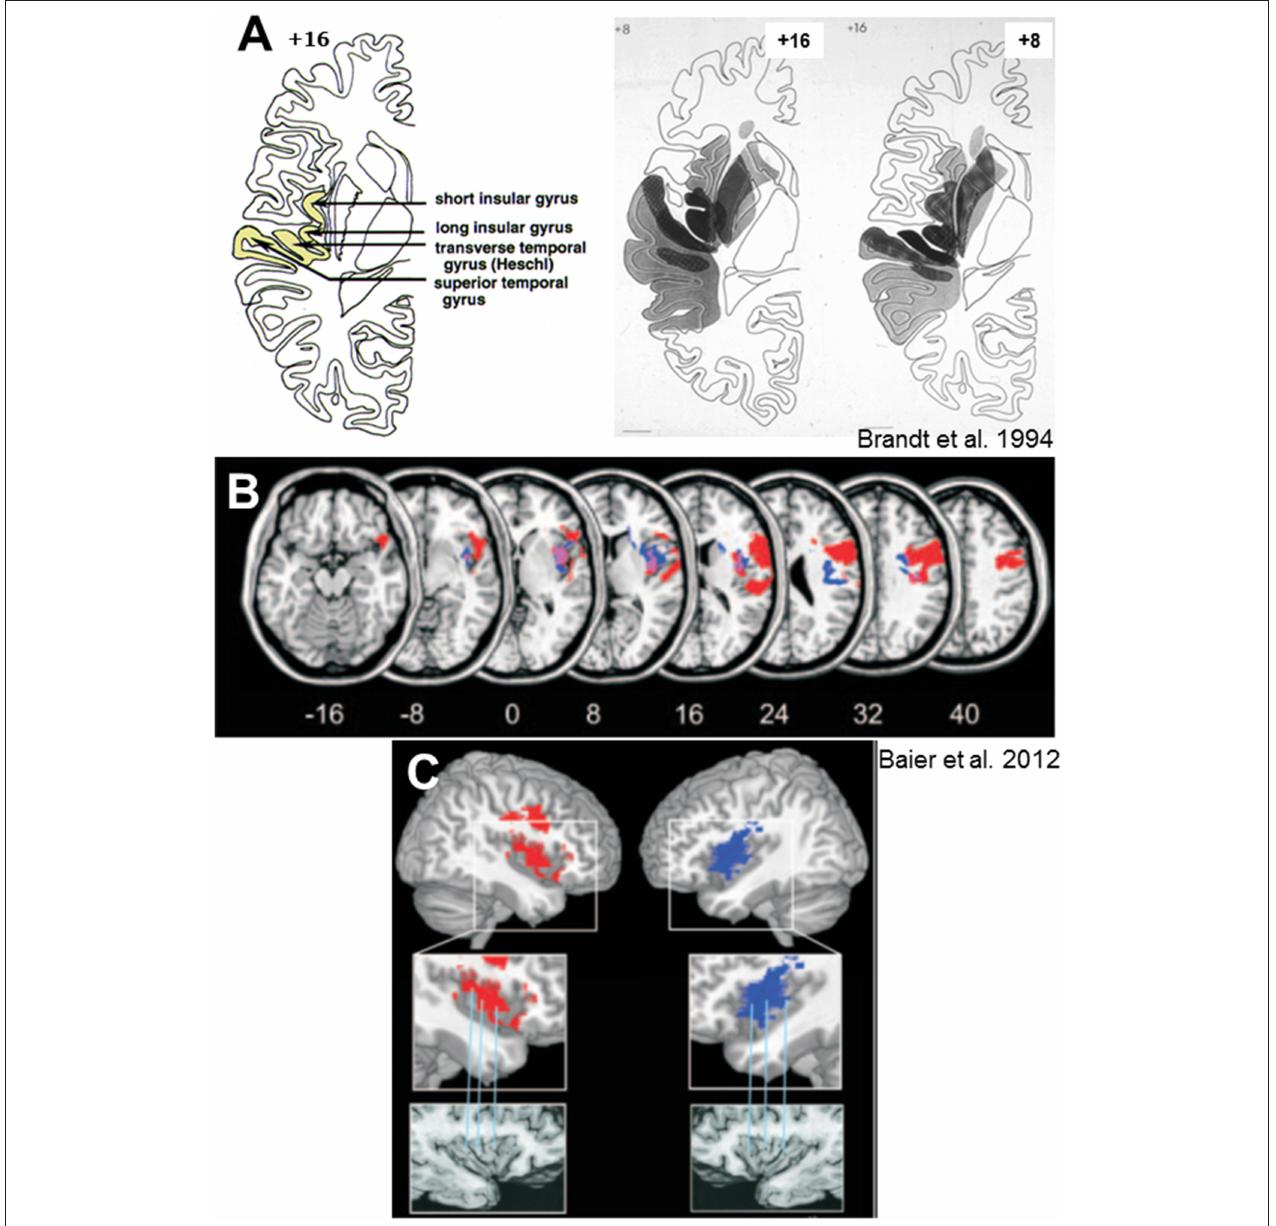
FIGURE 5 | Lesion sites of hemispheric infarctions that cause tilts of subjective visual vertical. (A) Collective presentation of infarcted areas taken from MRI scans and projected onto sections of the atlas of Duvernoy (81) in 7 patients with clearly demarcated infarctions of the middle cerebral artery which caused significant contralateral SVV tilts. Overlapping areas of infarctions (7 of 7 in black) are centered at the posterior part of the insula, involving the short and long insular gyri, the transverse temporal gyrus, and the superior temporal gyrus [from Brandt et al. (55)]. (B) Statistical voxelwise lesion-behavior mapping (VLBM) analysis comparing 32 patients with acute right-sided infarctions (RBD) and 22 patients with acute left-sided infarctions (LBD) with respect to absolute tilt of subjective visual vertical ( t -test statistic). Presented are all voxels that survived a correction for multiple comparisons using a 1% false discover rate cutoff threshold. Overlay of the statistical map from LBD patients (blue color), flipped to the right hemisphere, and the statistical map of the RBD patients (red color). Overlapping regions are shown in violet. From Baier et al. (79) (C) Illustration of the affected parts of the insula using the atlas of Duvernoy (81). Right insular lesions in red, left insular lesions in blue. Affected are the circular insular sulcus, central insular sulcus, short insular gyrus, and long insular gyrus [From Baier et al. (79)].